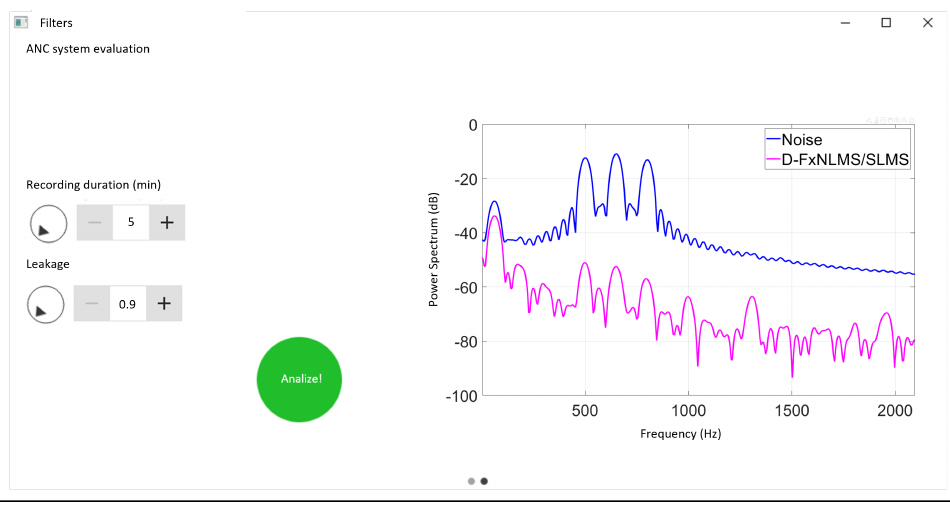
Figure 8. Power spectrum